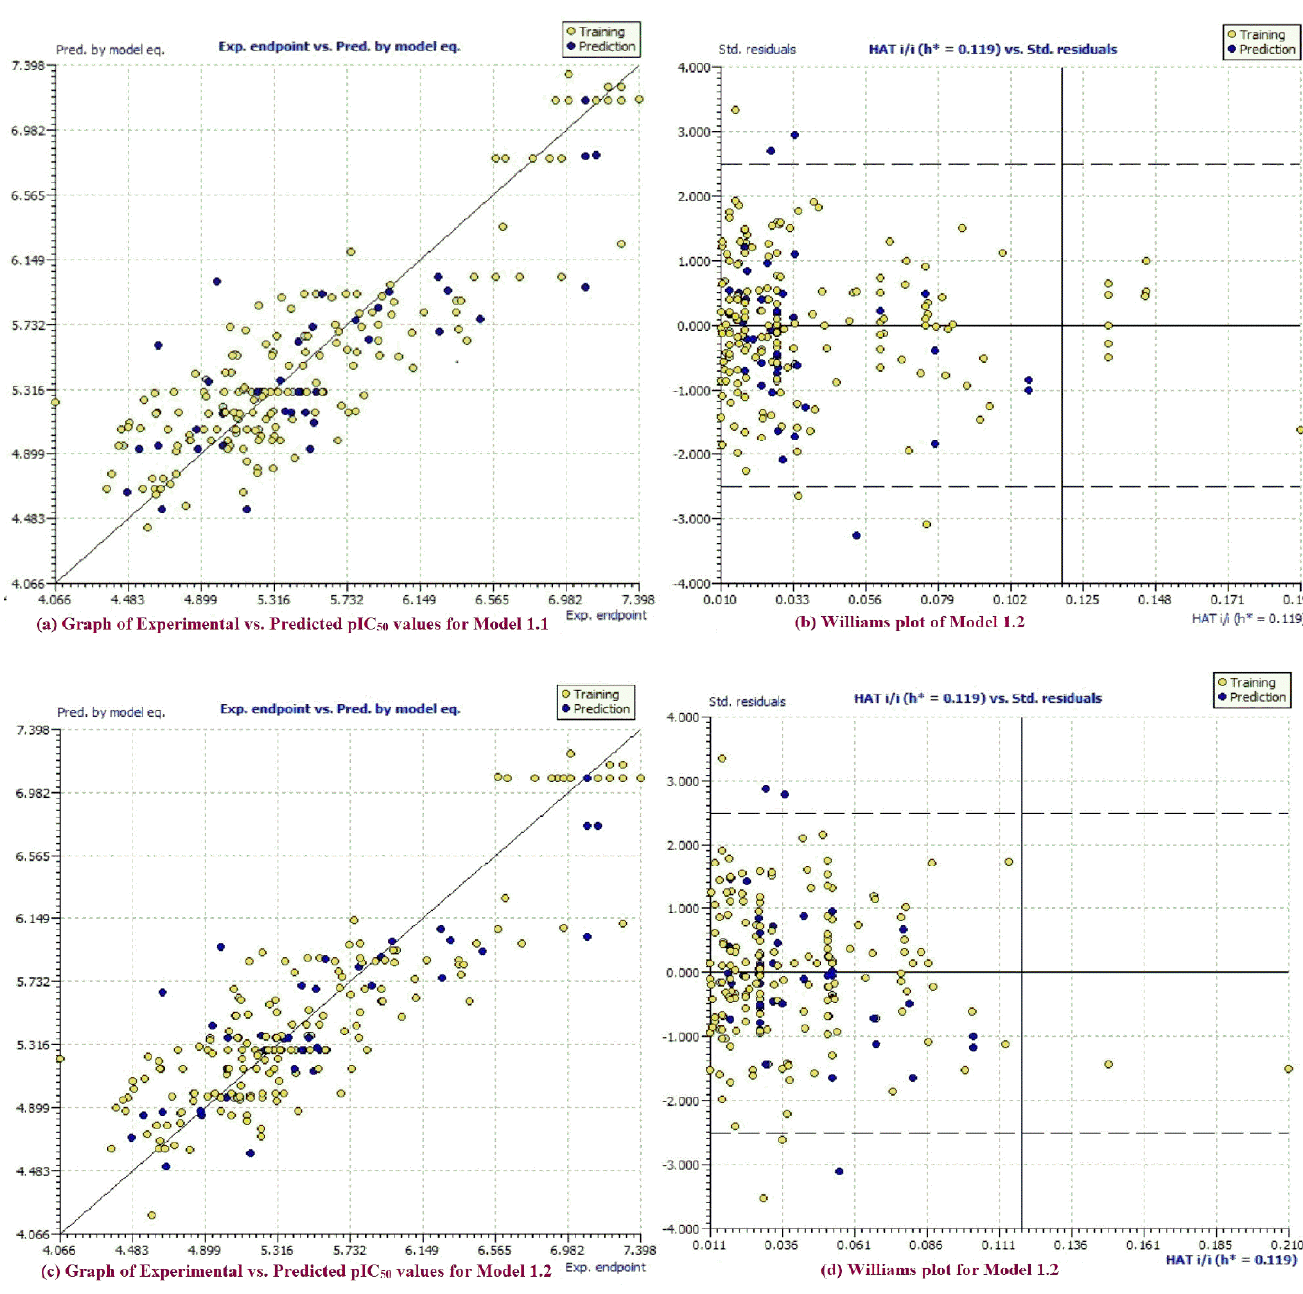
Figure 1. ( a ) Graph of experimental vs. predicted pIC 50 values for model 1.1; ( b ) Williams plot for model 1.1; ( c ) graph of Figure 1. (a) Graph of experimental vs. predicted pIC 50 values for model 1.1; (b) Williams plot for model 1.1; (c) graph of experimental vs. predicted pIC 50 values for model 1.2; ( d ) Williams plot for model experimental vs. predicted pIC 50 values for model 1.2; (d) Williams plot for model 1.2.